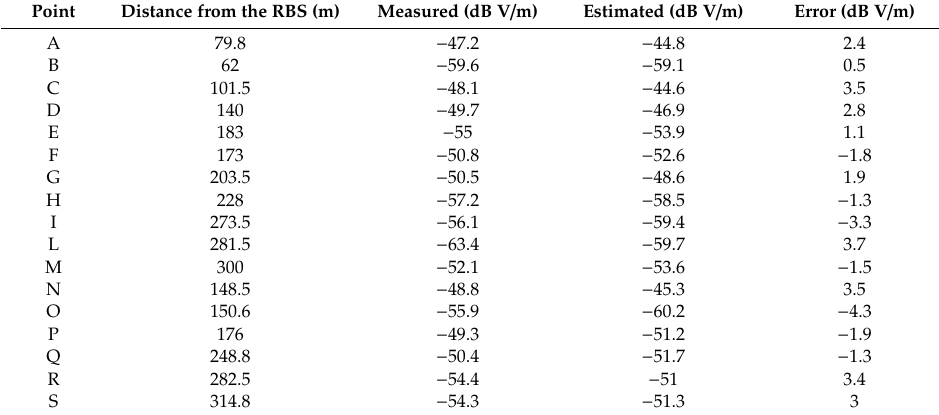
Table 3. Results of the Cala Gonone measurement campaign (1847.8 MHz, Kathrein 742212). Point Distance from the RBS (m) Measured (dB V / m) Estimated (dB V / m) Error (dB V / m)